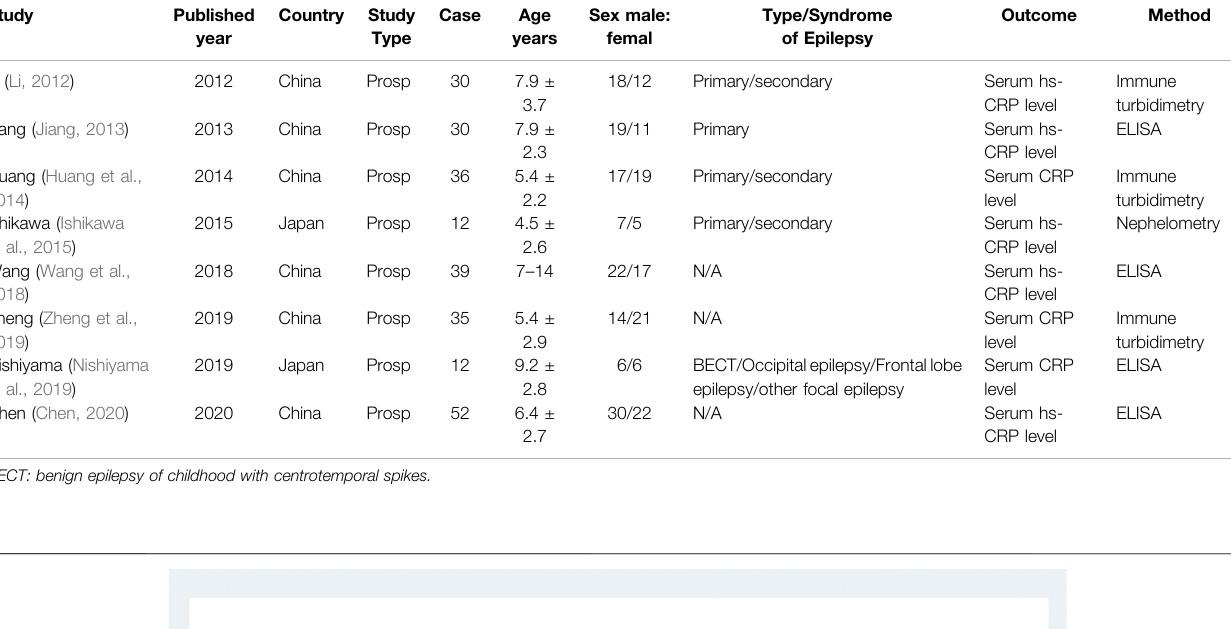
TABLE 1 | Characteristics of studies included in the meta-analysis.